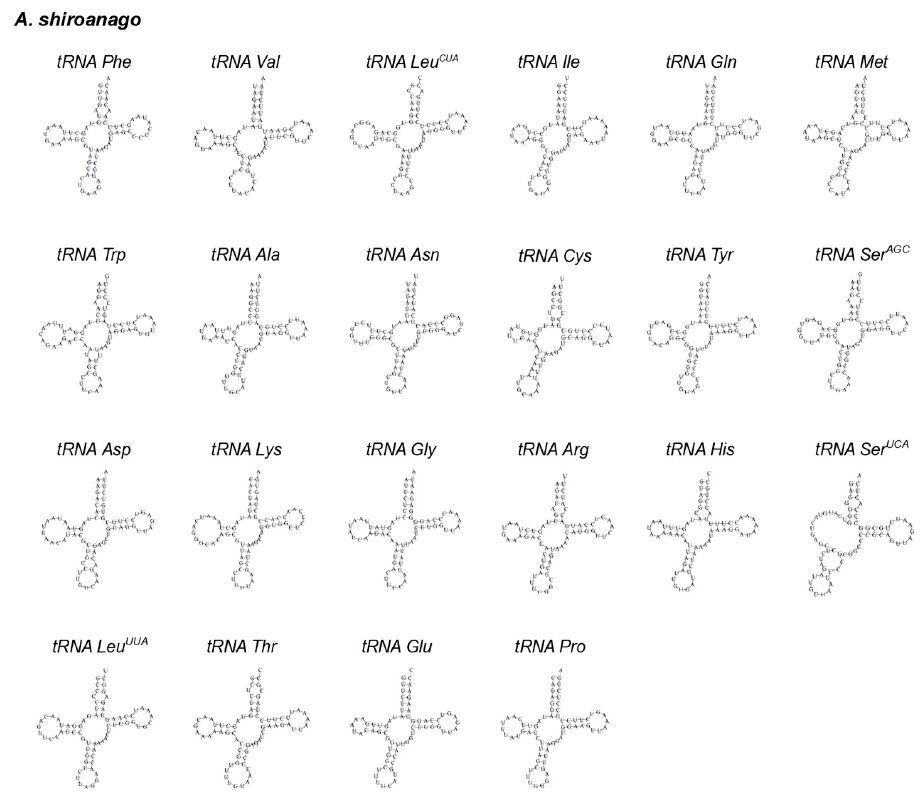
Figure 4. The cloverleaf structure of 22 tRNAs in the mitochondrial genome of A. shiroanago .